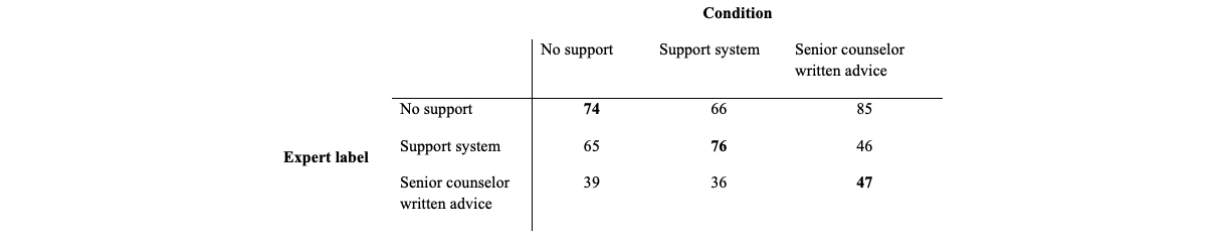
Figure 5. Confusion matrix for expert labeling of counselor responses.